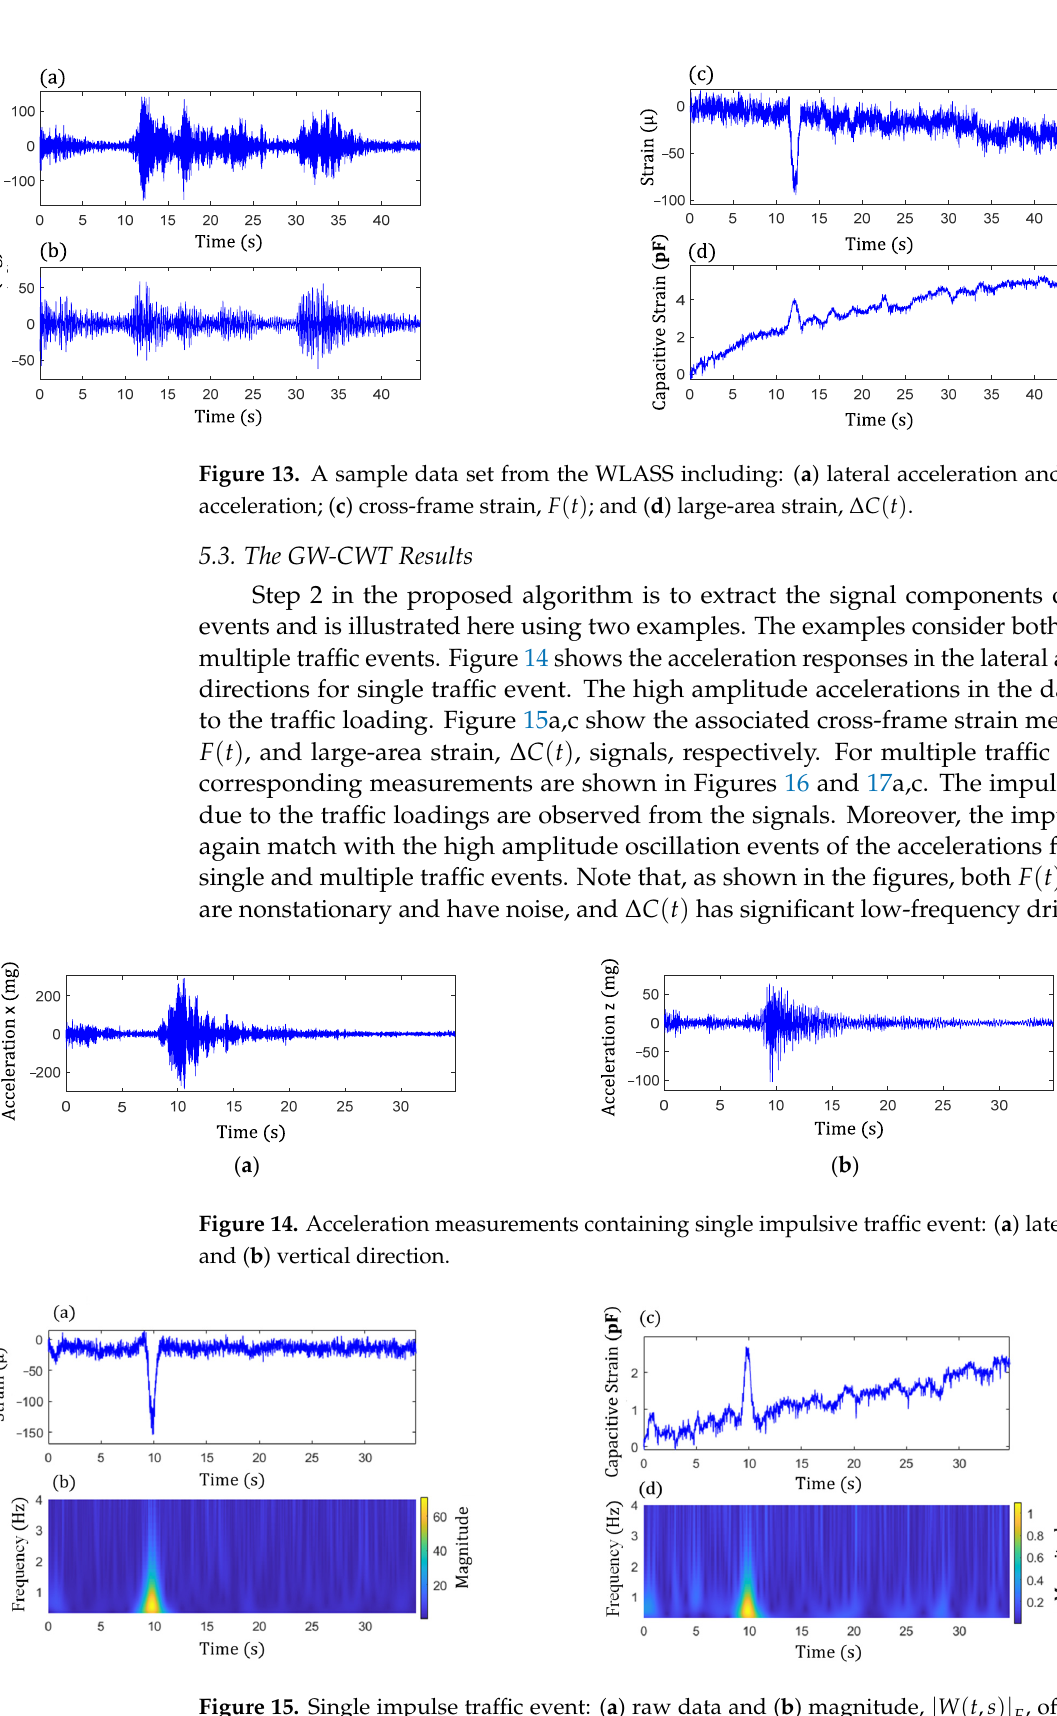
( b ) Figure 16. Acceleration measurements containing multiple impulse traffic events: ( a ) lateral direc- tion and ( b ) vertical direction. Figure 17. Multiple impulse traffic events: ( a ) raw data and ( b ) magnitude, |𝑊(𝑡,𝑠)| (cid:3007) , of cross-frame strain, 𝐹(𝑡) , and ( c ) raw data and ( d ) magnitude, |𝑊(𝑡,𝑠)| (cid:3004) , of large-area strain, ∆𝐶(𝑡) . 5.4. Fatigue Crack Monitoring Results 5.4.1. Automated Traffic Event Detection (Step 1) and Peak Identification (Step 2) The results from Step 1 for automated traffic event detection and Step 2 for peak identification in the proposed algorithm are discussed here. Automated traffic event de- tection in Step 1 was performed based on the measured cross-frame strain, 𝐹(𝑡) , to iden- tify impulsive traffic events for robustly extracting the amplitudes for the GM-CWT re- sults. The cross-frame strain, 𝐹(𝑡) , was used for this purpose because it indirectly captures the traffic loading and has relatively low noise, hence more clear peaks. Subsequently, the